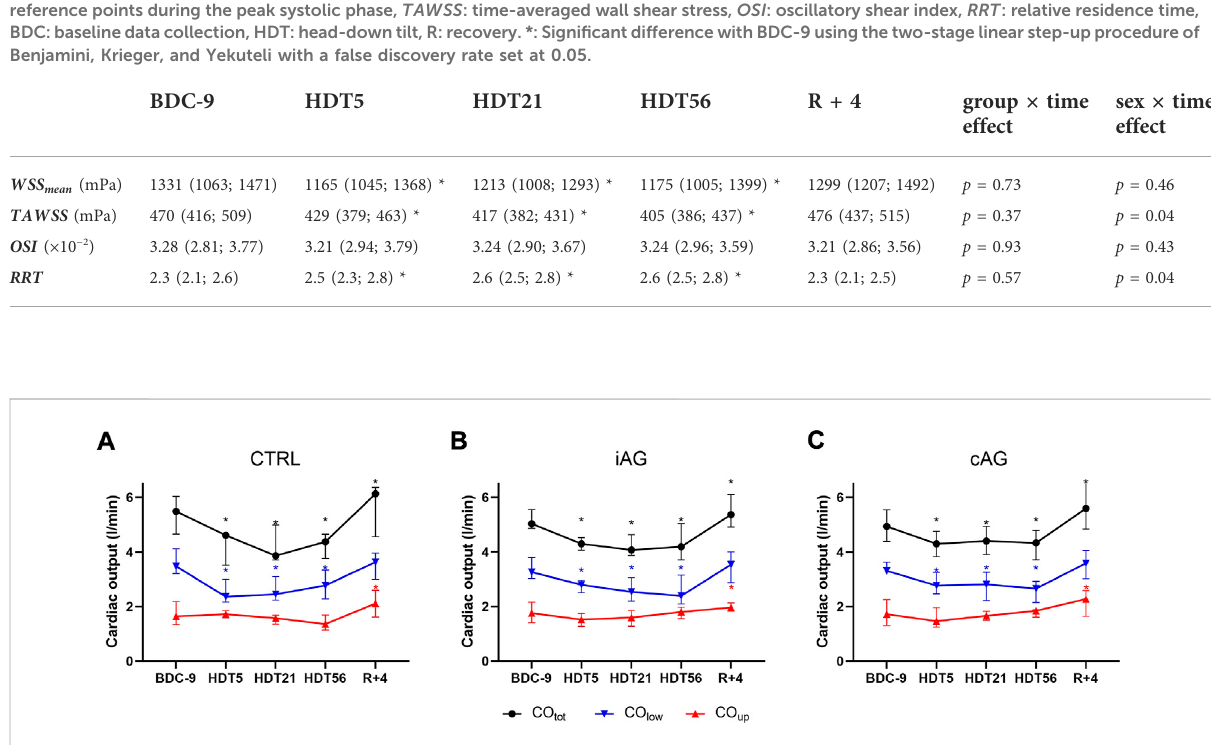
FIGURE 3 Changes in total cardiac output, as well as cardiac output allocated to the lower and upper body ( CO tot , CO low , and CO up , respectively) in each group all over the study. (A) control (CTRL) group; (B) intermittent arti fi cial gravity (iAG) group; (C) continuous arti fi cial gravity (cAG) group. *:Signi fi cantdifferencewithBDC-9usingthetwo-stagelinearstep-upprocedureofBenjamini,Krieger,andYekuteliwithafalsediscoveryratesetat 0.05. BDC: baseline data collection, HDT: head-down tilt, R: